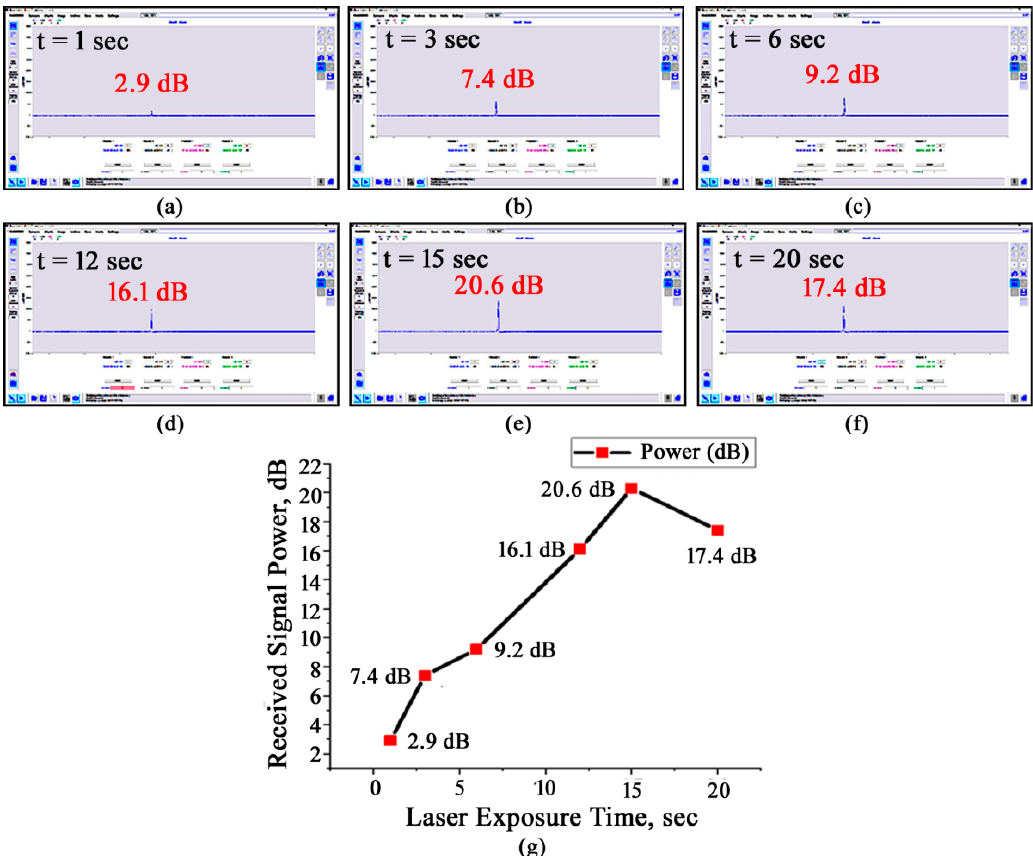
Figure 7. Interrogator-assisted measurement of the received signal power (at λ B = 1542 nm) reflected back from the 15-mm-long FBGs fabricated under different exposure times ( t ) of the laser beam using a laser power of 350 mW. ( a ) t = 1 s; ( b ) t = 3 s; ( c ) t = 6 s; ( d ) t = 12 s; ( e ) t = 15 s; ( f ) t = 20 s; ( g ) dependence of the received signal power on the exposure time of the laser beam.